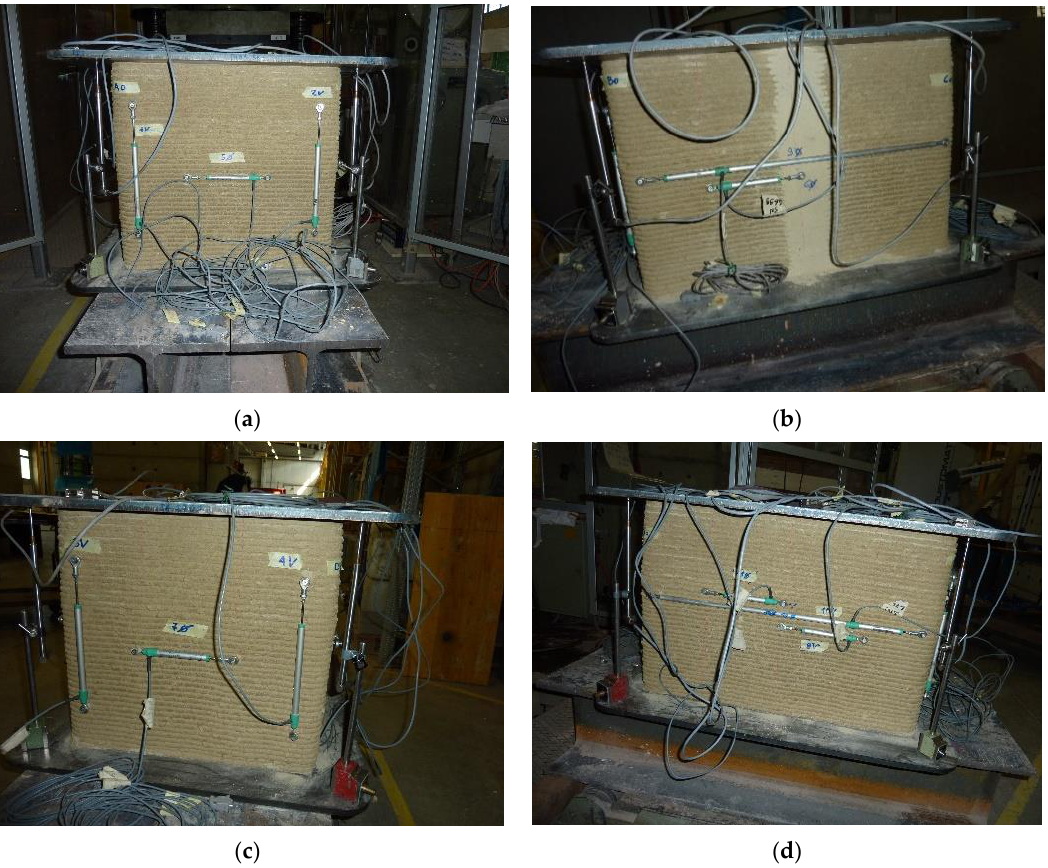
Figure 8. Side views of the LVDTs, listed from left to right: ( a ) LVDT VA, LVDT V1, LVDT H5, LVDT V2, LVDT VB on the short side face to the left of the operator; ( b ) LVDT VB, LVDT H9, LVDT H6, LVDT VC on the long side face in front of the operator; ( c ) LVDT VC, LVDT V3, LVDT H7, LVDT V4, LVDT VD on the short side face to the right of the operator; ( d ) LVDT VD, LVDT H10, LVDT H11, LVDT H8, LVDT VA on the long side face on the opposite side of the operator.